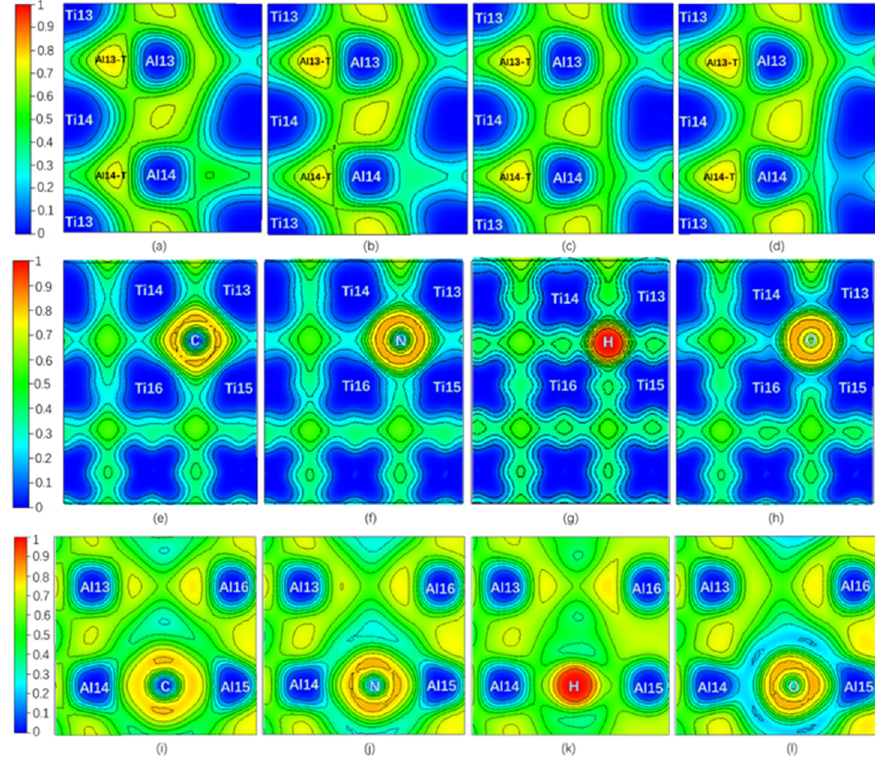
Figure 4. (Color on line.) ELF of twin model in presence of interstitial atom. ( a ) ELF on Layer7 with C. ( b ) ELF on Layer7 with N. ( c ) ELF on Layer7 with H. ( d ) ELF on Layer7 with O at Ti-rich octahedral interstitial positions I4. ( e ) ELF on the plane consisting of Ti13, Ti14, Ti15, Ti16, and C. ( f ) ELF on the plane consisting of Ti13, Ti14, Ti15, Ti16, and N. ( g ) ELF on the plane consisting of Ti13, Ti14, Ti15, Ti16, and H. ( h ) ELF on the plane consisting of Ti13, Ti14, Ti15, Ti16, and O at Ti-rich octahedral interstitial positions I4. ( i ) ELF on the plane consisting of Al13, Al14, and C. ( j ) ELF on the plane consisting of Al13, Al14, and N. ( k ) ELF on the plane consisting of Al13, Al14, and H. ( l ) ELF on the plane consisting of Al13, Al14, and O at Ti-rich octahedral interstitial positions I4.